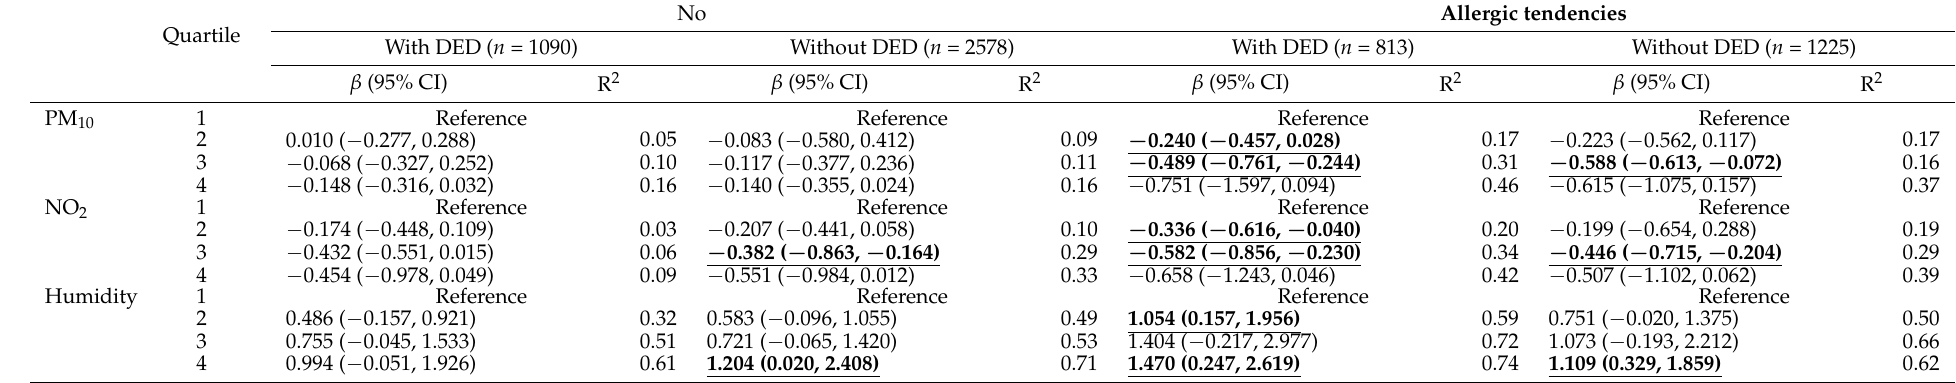
Table 5. Association (adjusted β and 95% CI) between ln (Lf) (mg/mL) and PM 10 , NO 2 or humidity for allergies (no/yes).